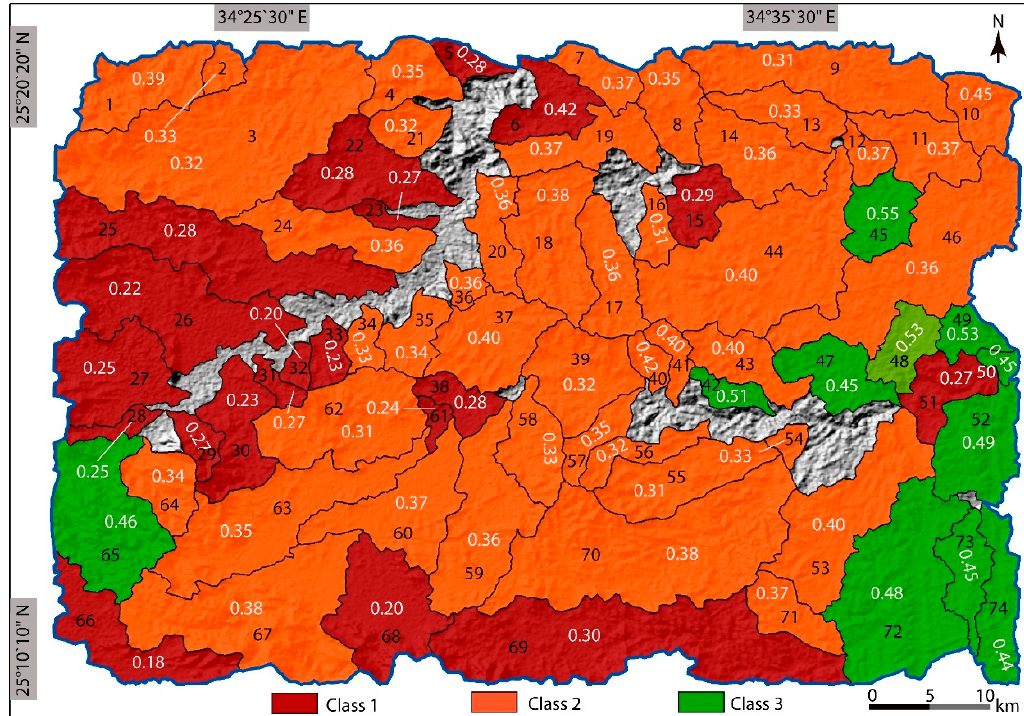
Figure 9. Map showing hypsometric integral index (H i ) values in white numbers and tectonic classes. Black numbers refer to the sub-catchment reference numbers.